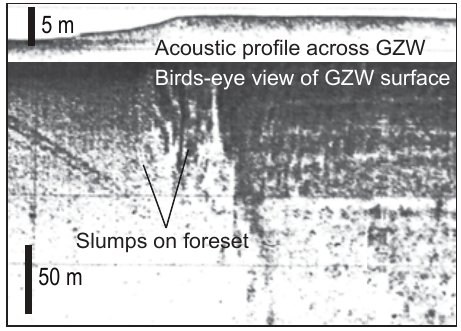
Figure 11. Side-scan sonar image from cruise NBP95-01 across a grounding zone wedge in the southern JOIDES Trough, showing slumps on the grounding zone wedge foreset